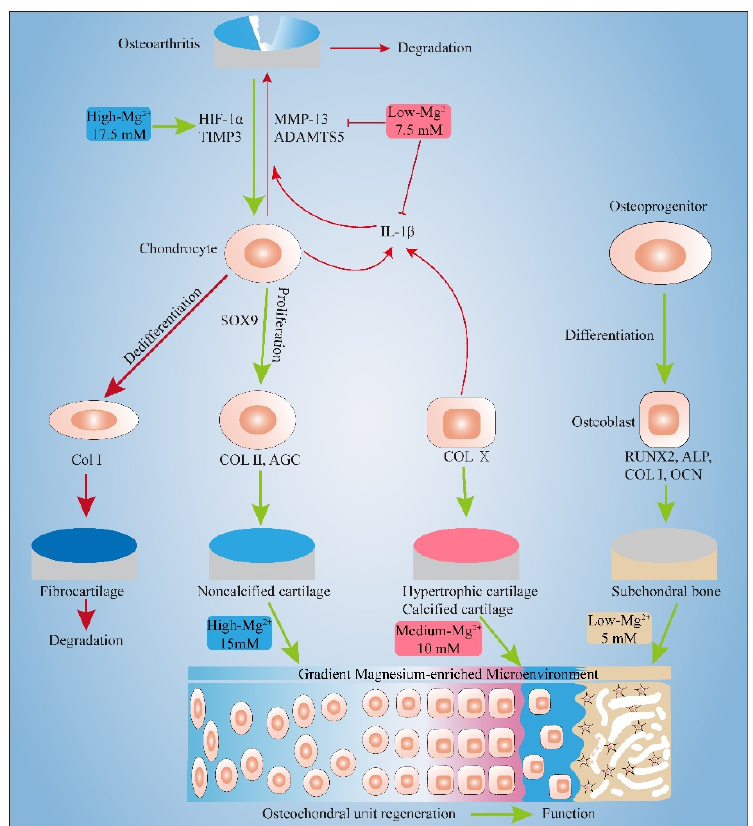
Figure 7. Gradient Mg 2+ -enriched Microenvironment promotes the formation of Noncalcified carti- lage, hypertrophic cartilage and subchondral bone. Appropriate concentrations of Mg 2+ also have an anti-inflammatory effect and pro-anabolism